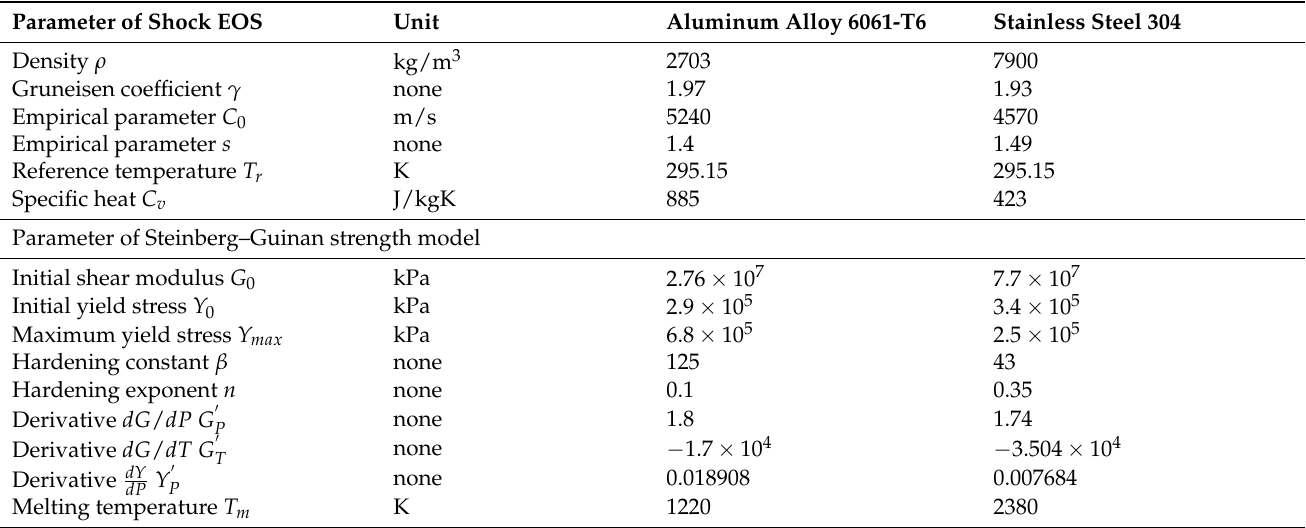
Table 1. Material properties used for impact